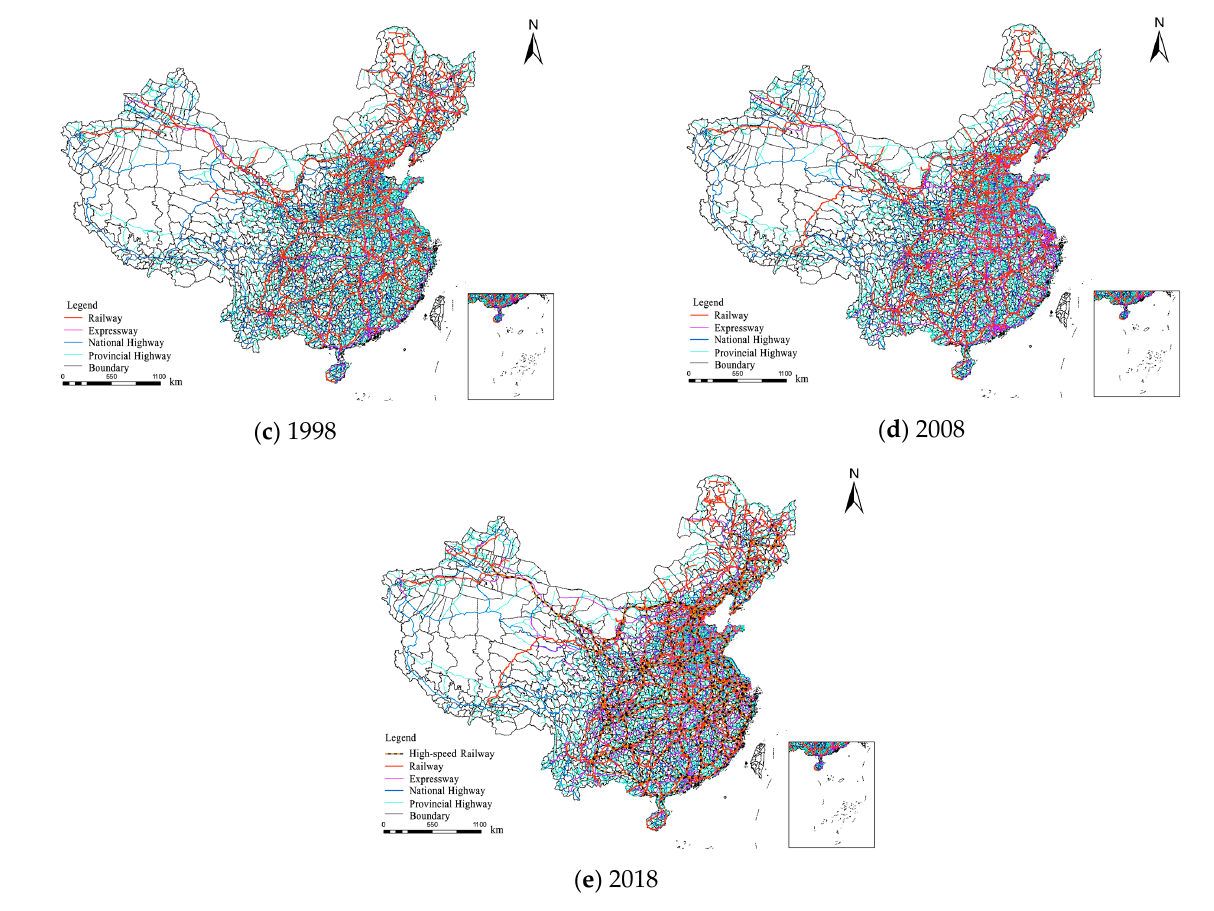
Figure 1. The traffic routes in China from 1978 to 2018. Table 1. Standard width of roadbed for different types of roads.